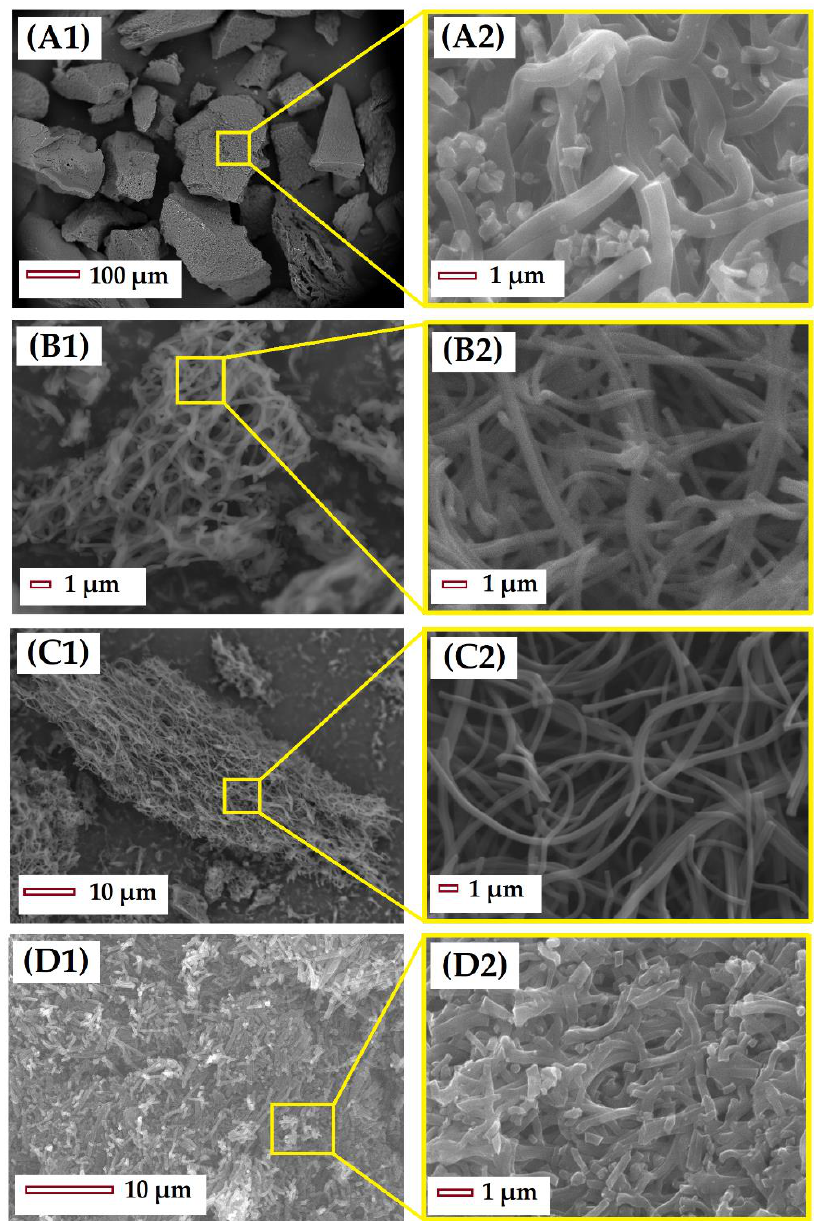
Figure 2. SEM images of CMF stabilized and carbonized: ( A ) S-250-C, ( B ) S-270-C, ( C ) S-280-C, and ( D ) S-300-C. The images on the right ( A2 , B2 , C2 , and D2 ) are zoomed in images of a region of the figures on the left ( A1 , B1 , C1 , and D1 ).